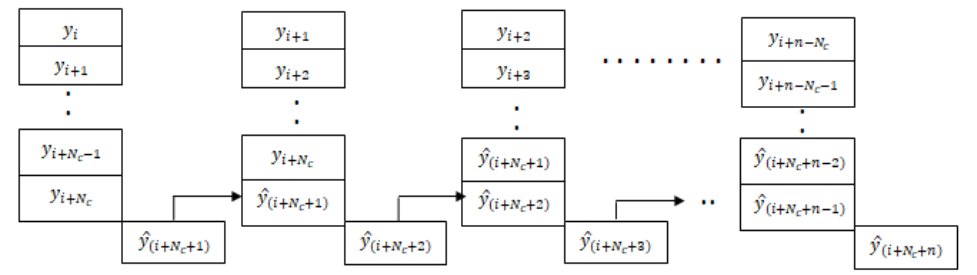
Figure 7. BGL prediction using time segmentation.